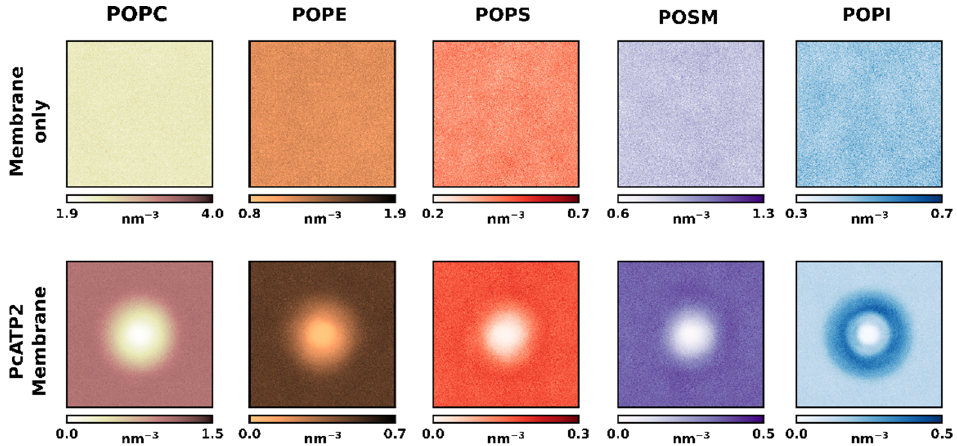
Figure 2. Density maps (in lipids nm − 3 ) of each lipid species of both leaflets across the membrane plane of the simulation box for both the control (without PcATP2) membranes ( top ) and the PcATP2 systems ( bottom ).